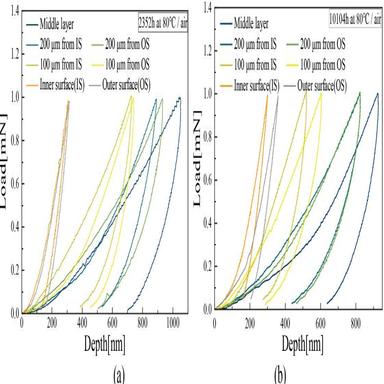
Effect of position on load-depth curve of PE80 aged 2352 h(a) and PE100 aged 10,104 h(b).